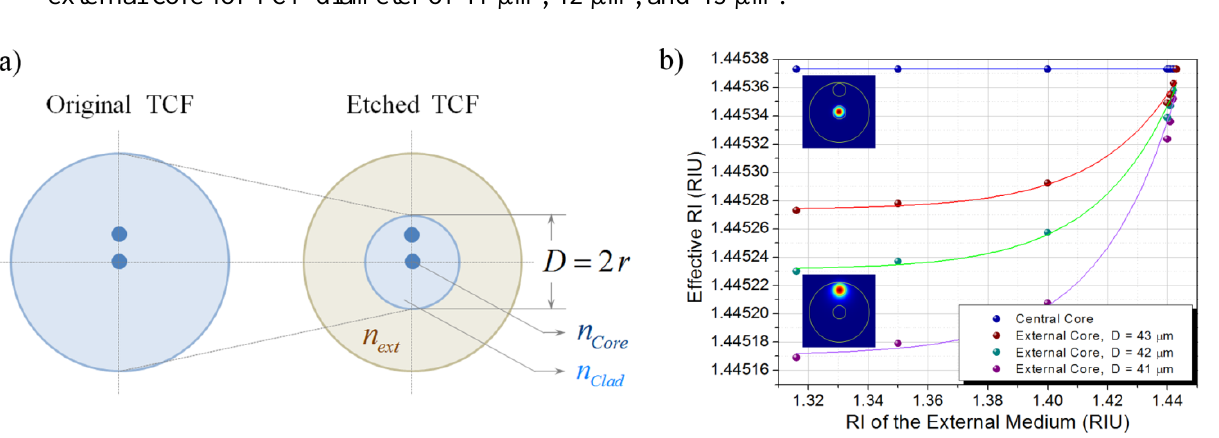
Figure 2. ( a ) Schematic of the TCF after the etching process; ( b ) ERI of the central and external core for TCF diameter of 41 µm, 42 µm, and 43